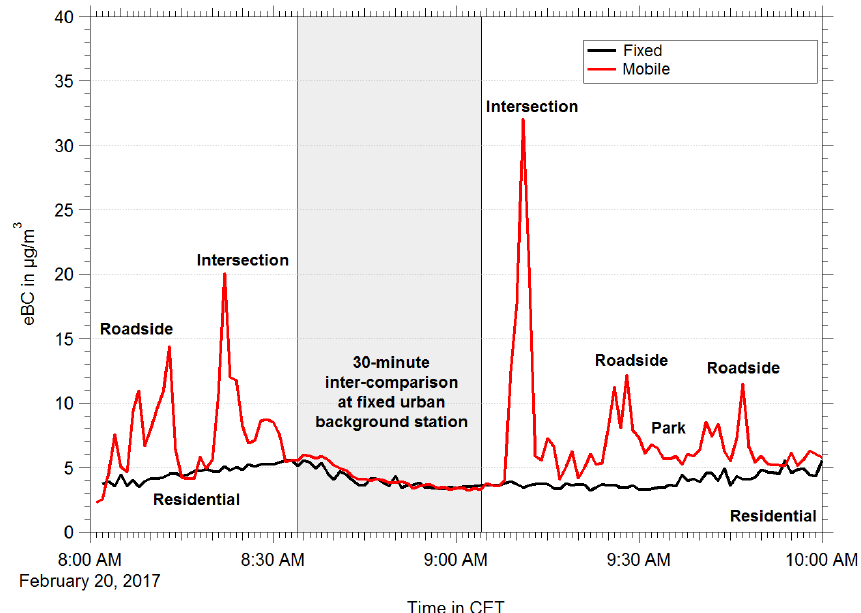
Figure 10. Measurements of eBC mass concentrations at 1-min resolution from the morning run of 20 February 2017. The black line represents eBC measurements at the fixed station in the S.Sisto garden (MAAP). The red line represents the mean data from the mobile measurements (two aethalometers, AE51) taken in the backpacks along the 9 km route including the 30-min stay (grey area) at the urban background area to compare with the reference instrument in the fixed station (black). The mean deviation between the two AE51 aethalometers was 0.068 µ g · m − 3